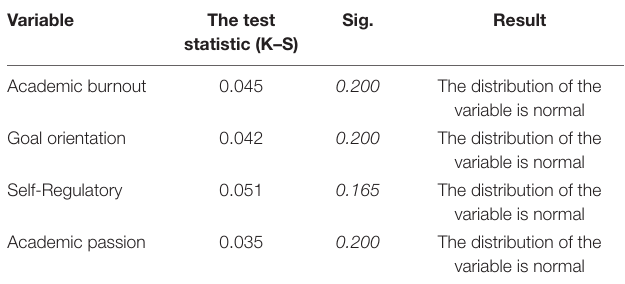
TABLE 3 | Evaluation of normality of variables by the Kolmogorov–Smirnov test.